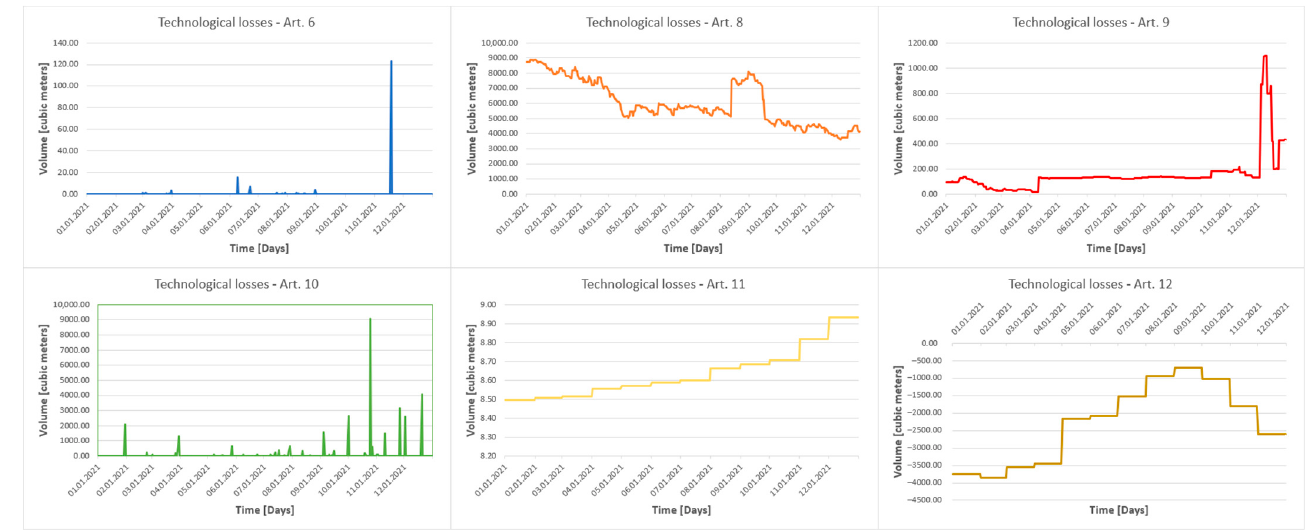
Figure 3. Structure of losses by types (source: authors based on the analysed data).